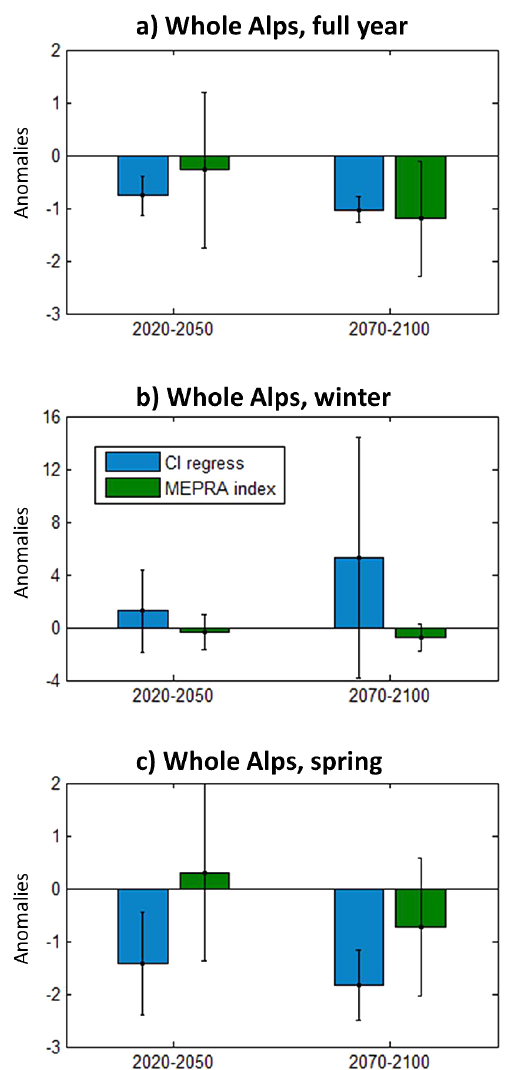
Figure 10. Changes in MEPRA index vs. changes in composite in- dex regression model (in terms of anomalies) on the scale of the en- tire French Alps for the full avalanche year (a) , and the winter (b) and spring (c)